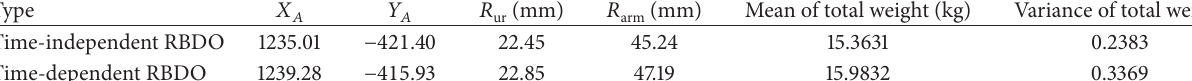
Table 7: Comparison of optimal design results between time-independent RBDO and proposed time-dependent RBDO.